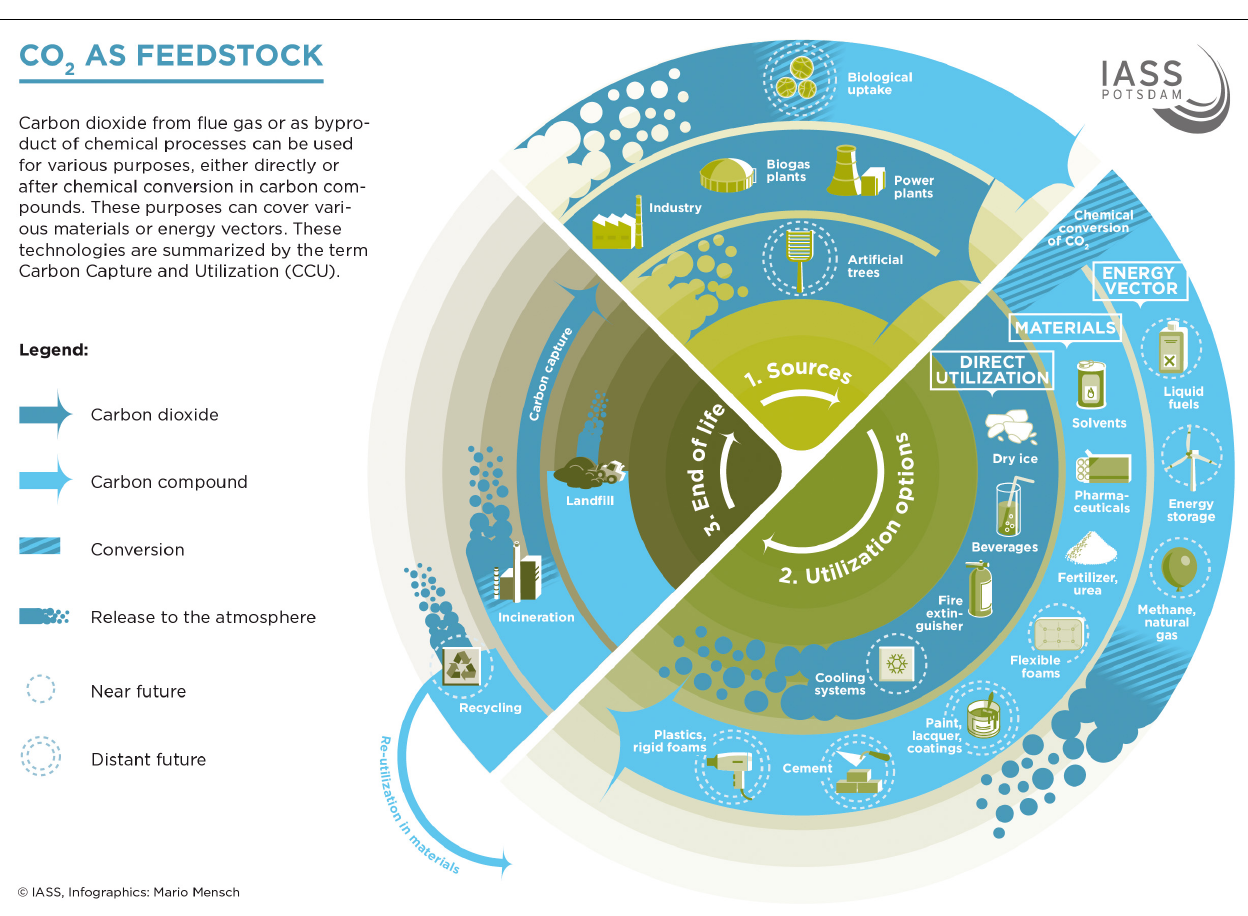
Frontiers in Energy Research |